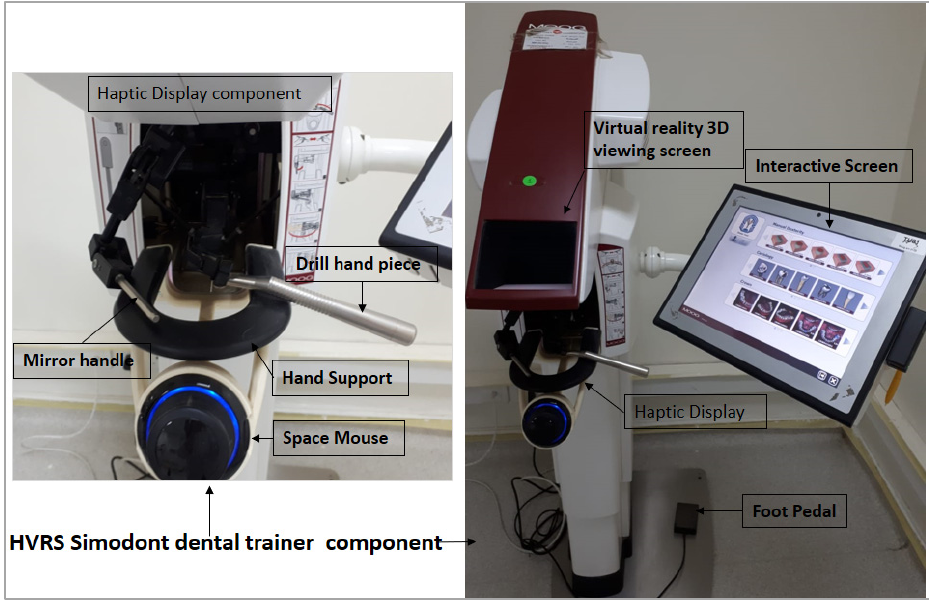
Figure 1. Haptic virtual reality simulator (HVRS) Simodont Dental trainer.